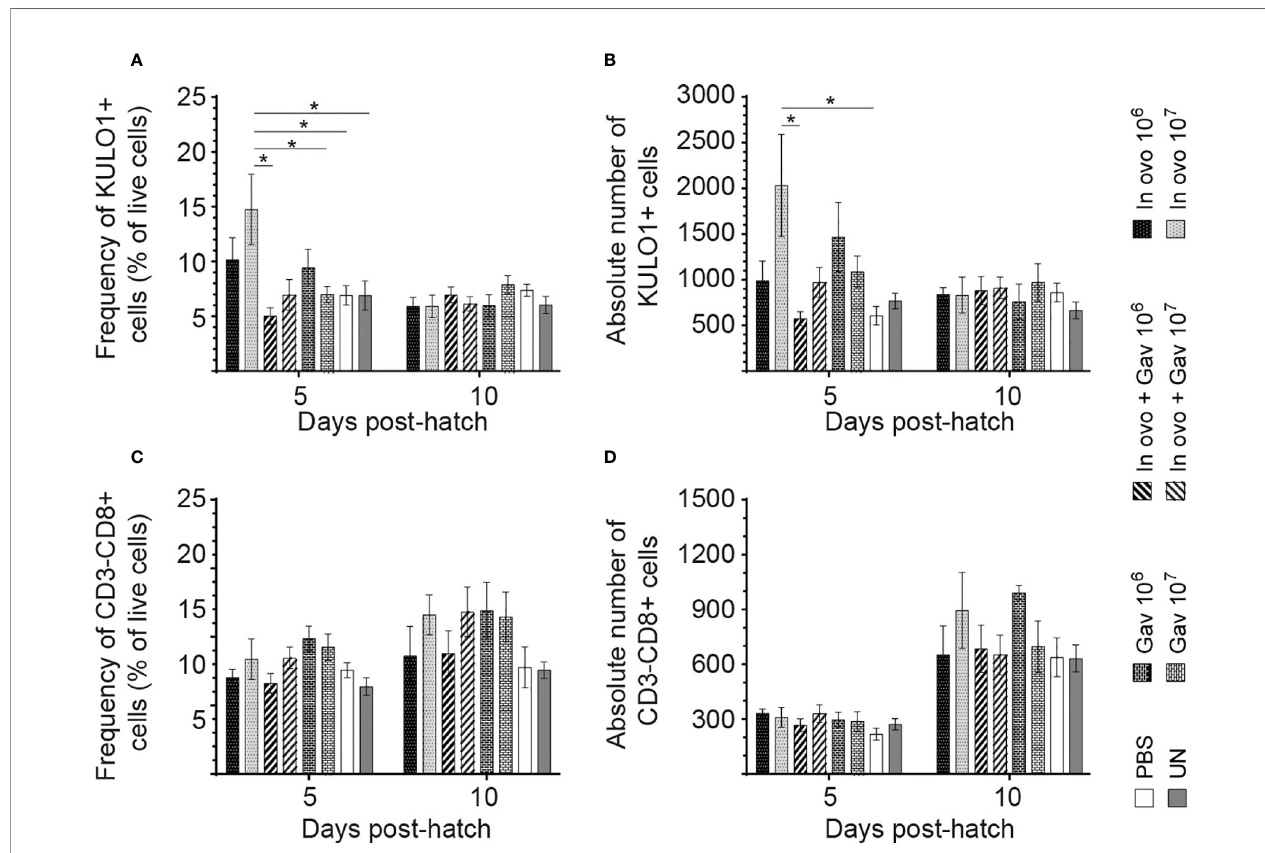
FIGURE 5 | Changes in the frequency of spleen innate immune cells mediated by lactobacilli inoculation. Spleen samples were collected at days 5 and 10 post- hatch from all treatment groups: groups 1 and 2 received 10 6 and 10 7 CFUs of lactobacilli cocktail in ovo , respectively, at embryonic day eighteen; groups 3 and 4 received 10 6 and 10 7 CFUs of lactobacilli, respectively, via both in ovo and oral gavage (on days 1, 7, 14, 21, 28 post-hatch); groups 5 and 6 received 10 6 and 10 7 CFUs of lactobacilli, respectively, via oral gavage; group 7 was served as a negative control group and was injected with phosphate-buffered saline (PBS); group 8 remained untreated (UN). Spleen mononuclear cells were stained and fl ow cytometric analysis was performed to determine the respective frequency and absolute numbers of monocyte/macrophages (KUL01 + ; A, B ) and CD3 - CD8 + T cells (C, D) . Statistical signi fi cance among treatment groups was calculated using SAS Proc GLM (General Linear Model) followed by Tukey ’ s comparison test. Error bars represent standard errors of the mean. Results were considered statistically signi fi cant if P < 0.05. Bars with asterisks represent a signi fi cant difference among treatments. The data are representative samples from 6 individual